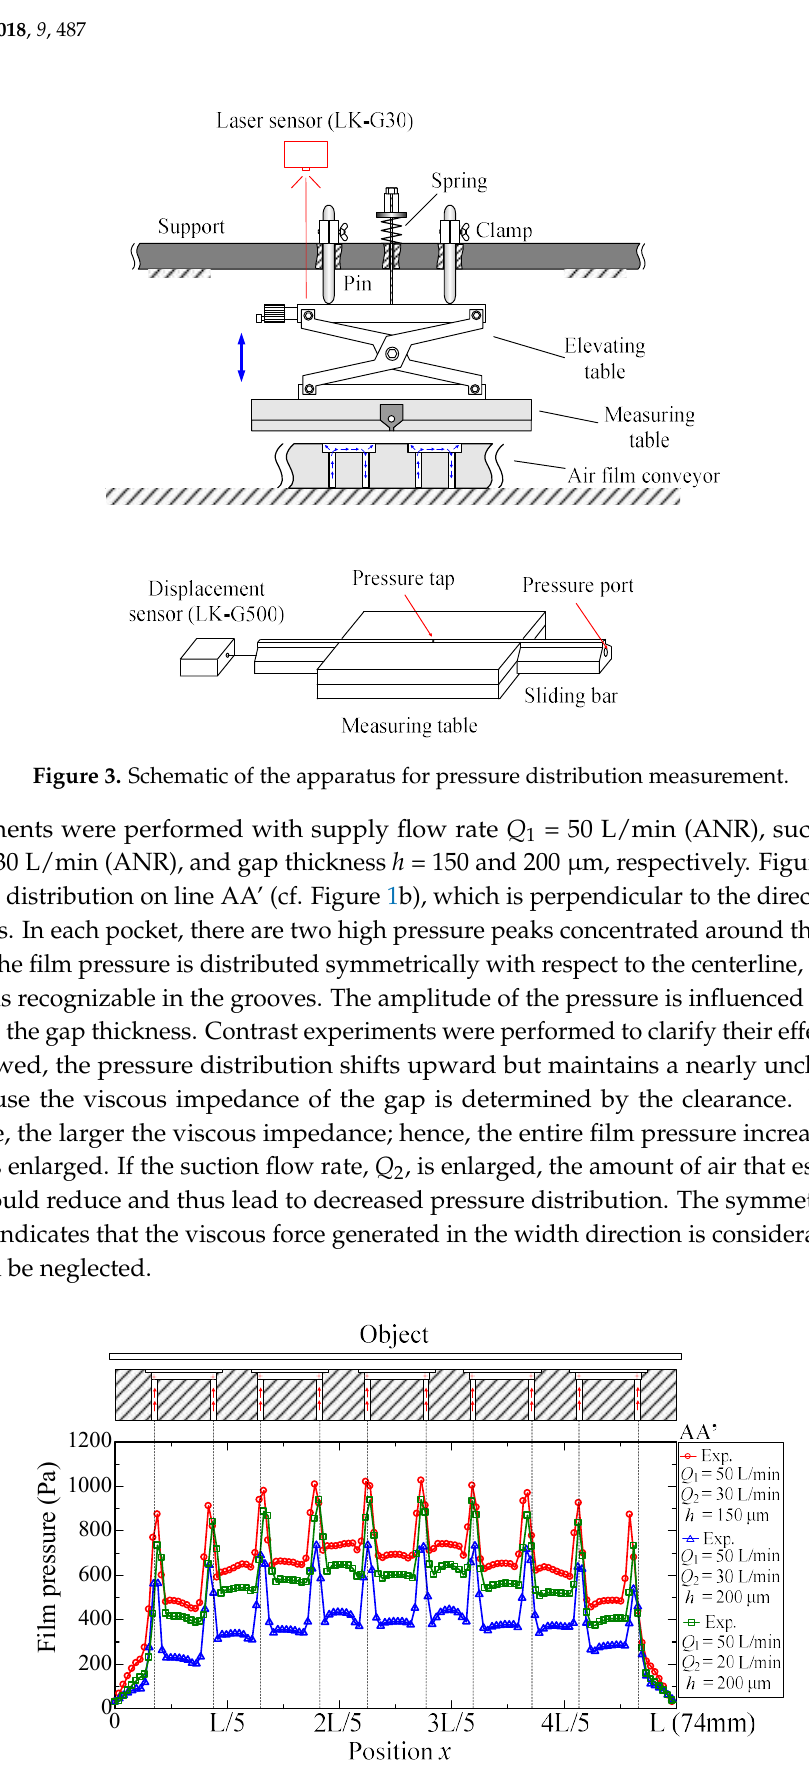
Figure 4. Film pressure distribution.